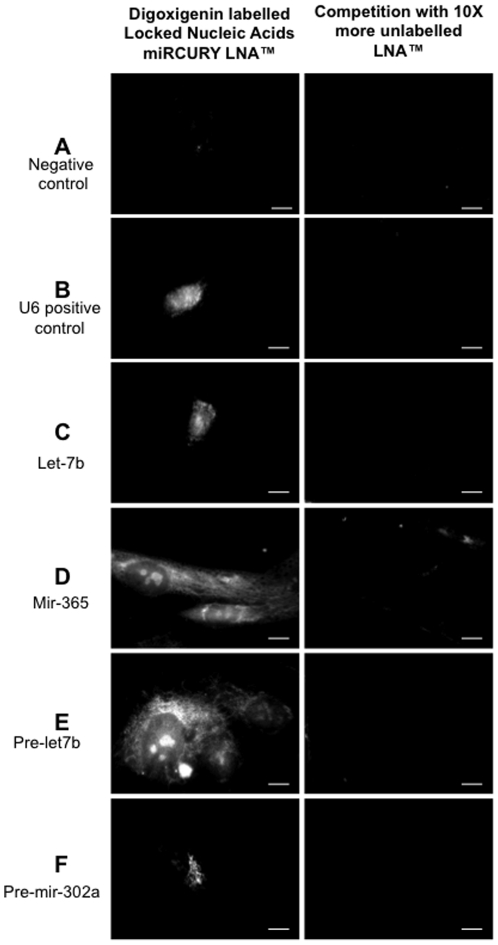
Specificity of the locked nucleic acid (LNA) probes for the detection of miR and pre-miR using in situ hybridization.Using 2.5 pmol of locked nucleic acid (LNA) probes prelabelled with digoxigenin, we determined in situ hybridization patterns of scramble miR (A; negative control), U6 small nuclear RNA (B; positive control), let-7b (C), mir-365 (D), pre-let-7b (E) and pre-mir-302a (F) probes (lane 1). In the second lane, Digoxigenin-labeled probes were competed with excessive amount (25 pmol ie 10× more) of unlabeled probes. Most of the signal observed in the panels of the first lane are absent from the panels in the second lane. Scale bars = 10 µm. Images are not scaled to the same intensity range. Positive in situ hybridization signals showed were normalized by scramble mirna signal intensity (negative control).